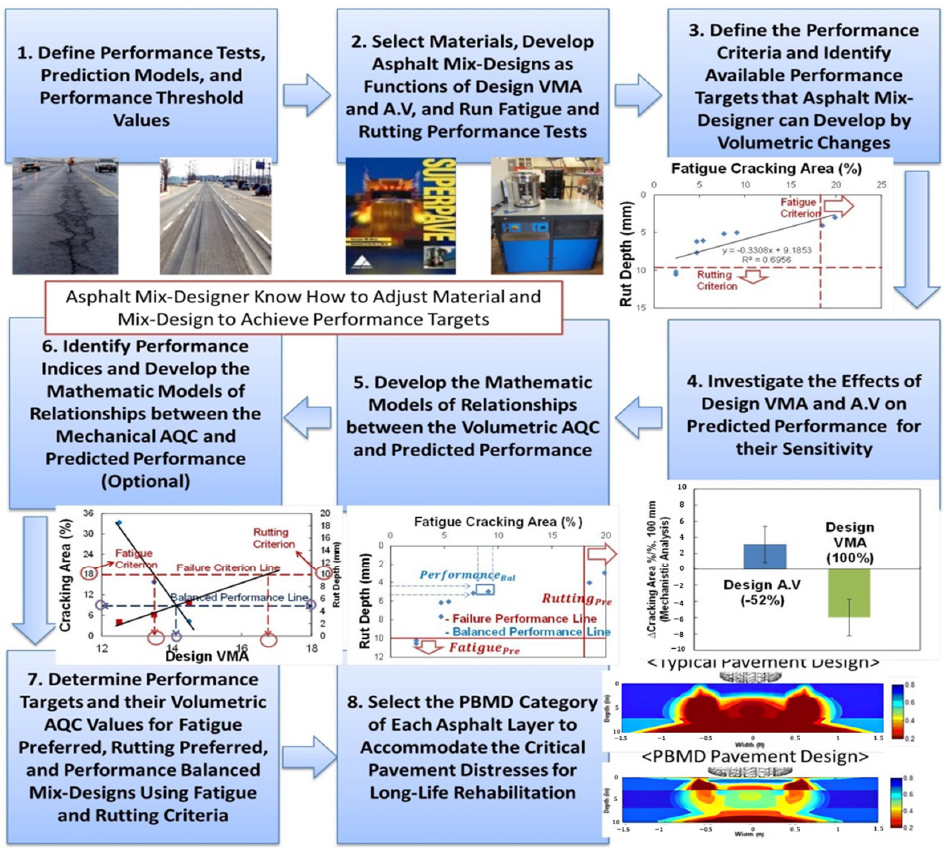
Figure 3. Suggested Performance-based mix design protocol.